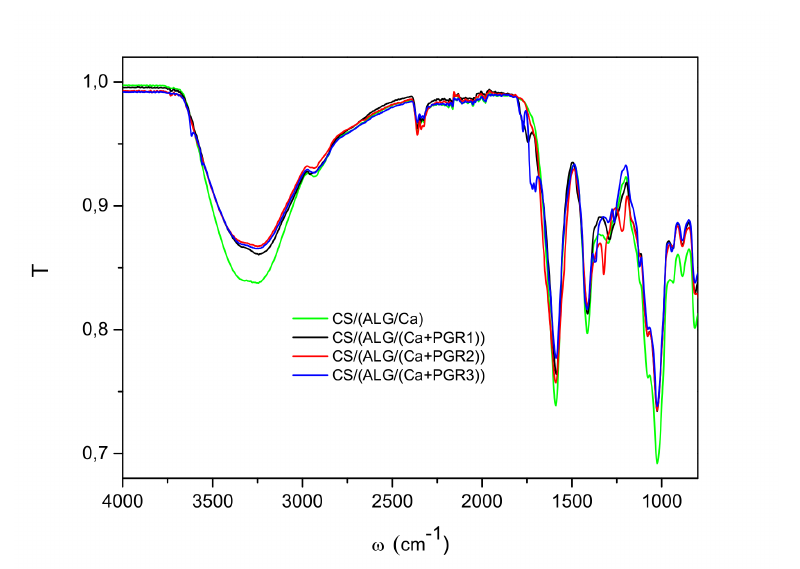
Figure 1. Characteristic FTIR spectra of dry microcapsule formulations; CS/(ALG/Ca) (green line); CS/(ALG/(Ca+PGR1)) (black line), CS/(ALG/(Ca+PGR2)) (red line) and CS/(ALG/(Ca+PGR3)) (blue